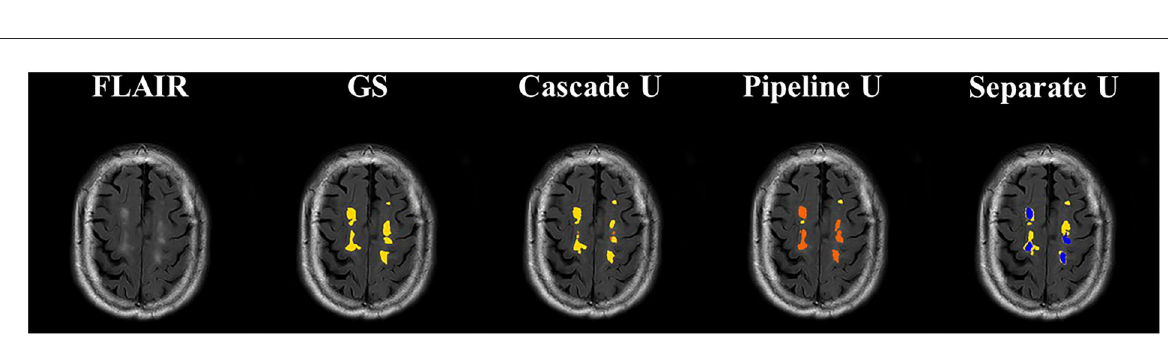
study, 90% (223/253) of subjects recruited were at an early stage, with a total Fazekas score lower than 3 (range 0 to 6). The median of pvWMHV and dWMHV on each subject was 0.82 ml and 0.44 ml, respectively. Previous studies had validated that accurate segmentation of small WMHs was more challenging compared with large WMHs ( 13, 16, 33). Although